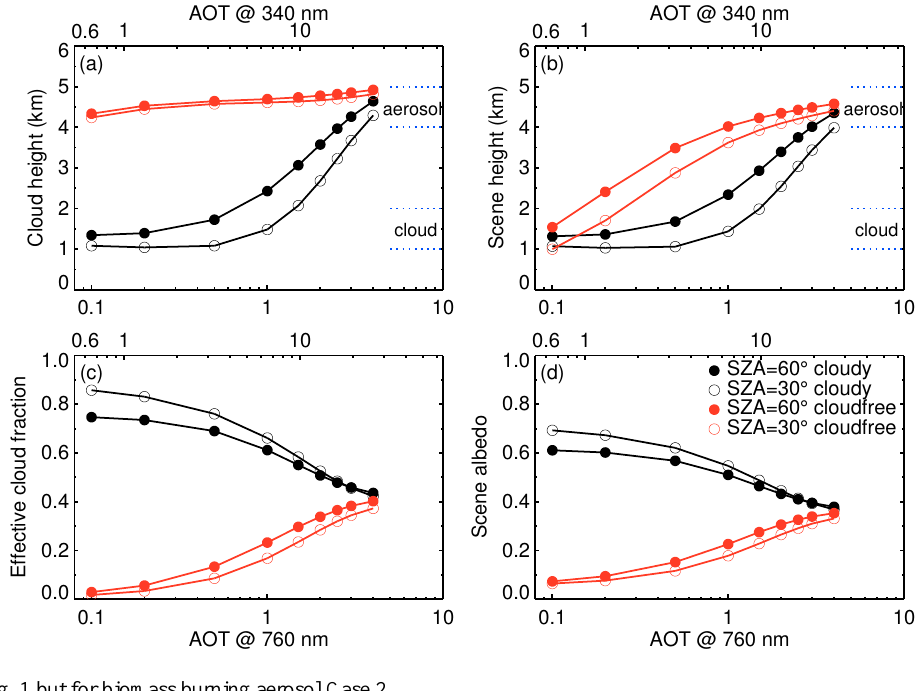
Fig. 2. Same as Fig. 1 but for biomass burning aerosol Case 2.